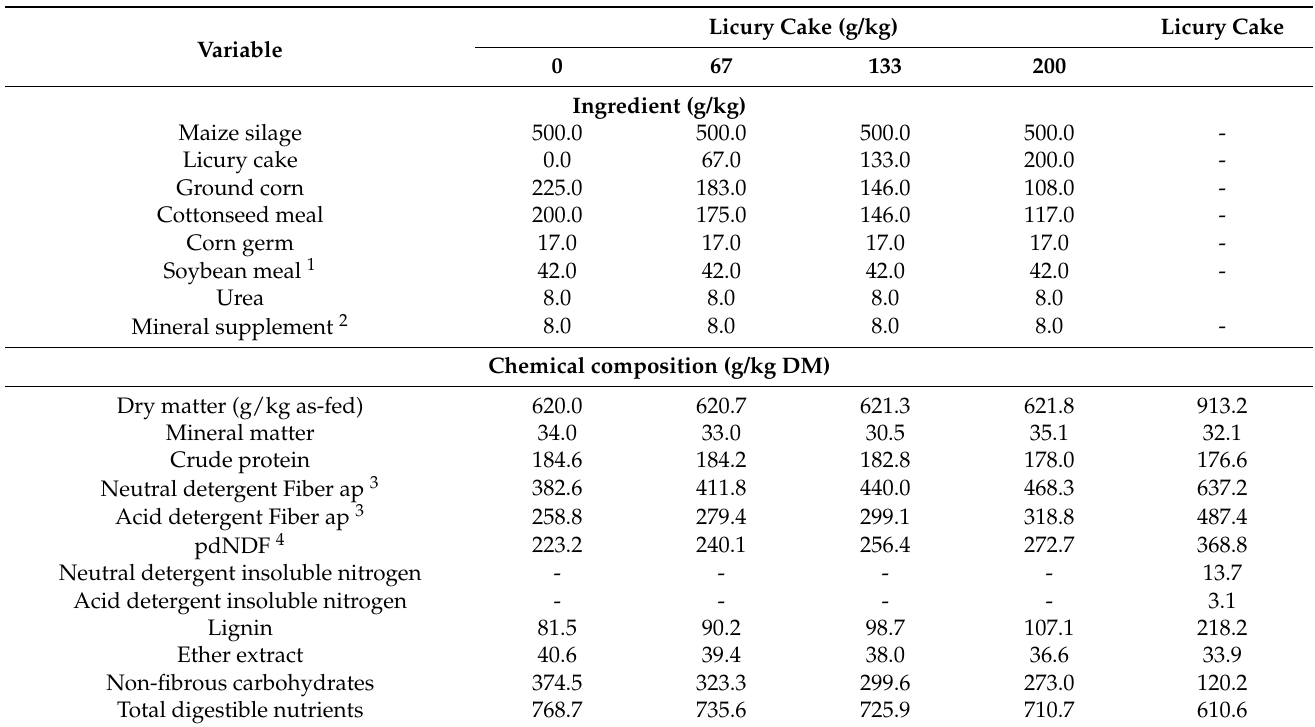
Table 1. Proportion of ingredients and analyzed chemical composition of the diets including li- cury